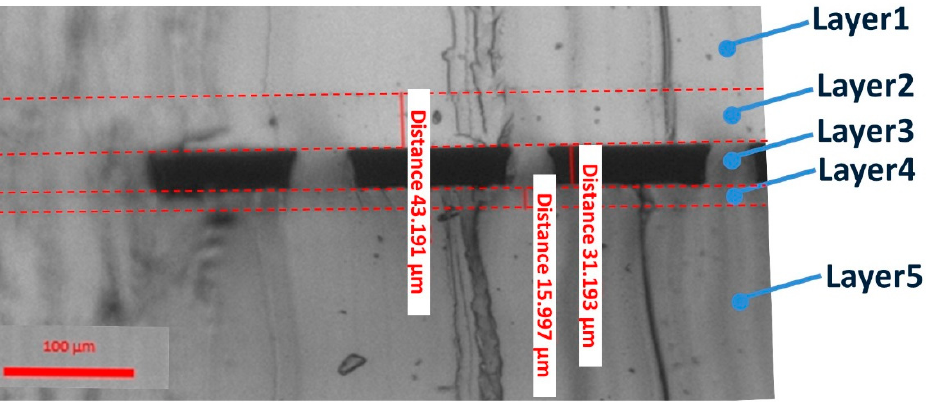
Figure 4. Side view of real pump chip dimensions. Layer 1: top electrode layer (electrode channel not shown here); layer 2: top membrane layer; layer 3: fluid channel layer; layer 4: bottom thin membrane layer; layer 5: bottom electrode layer (electrode channel not shown).